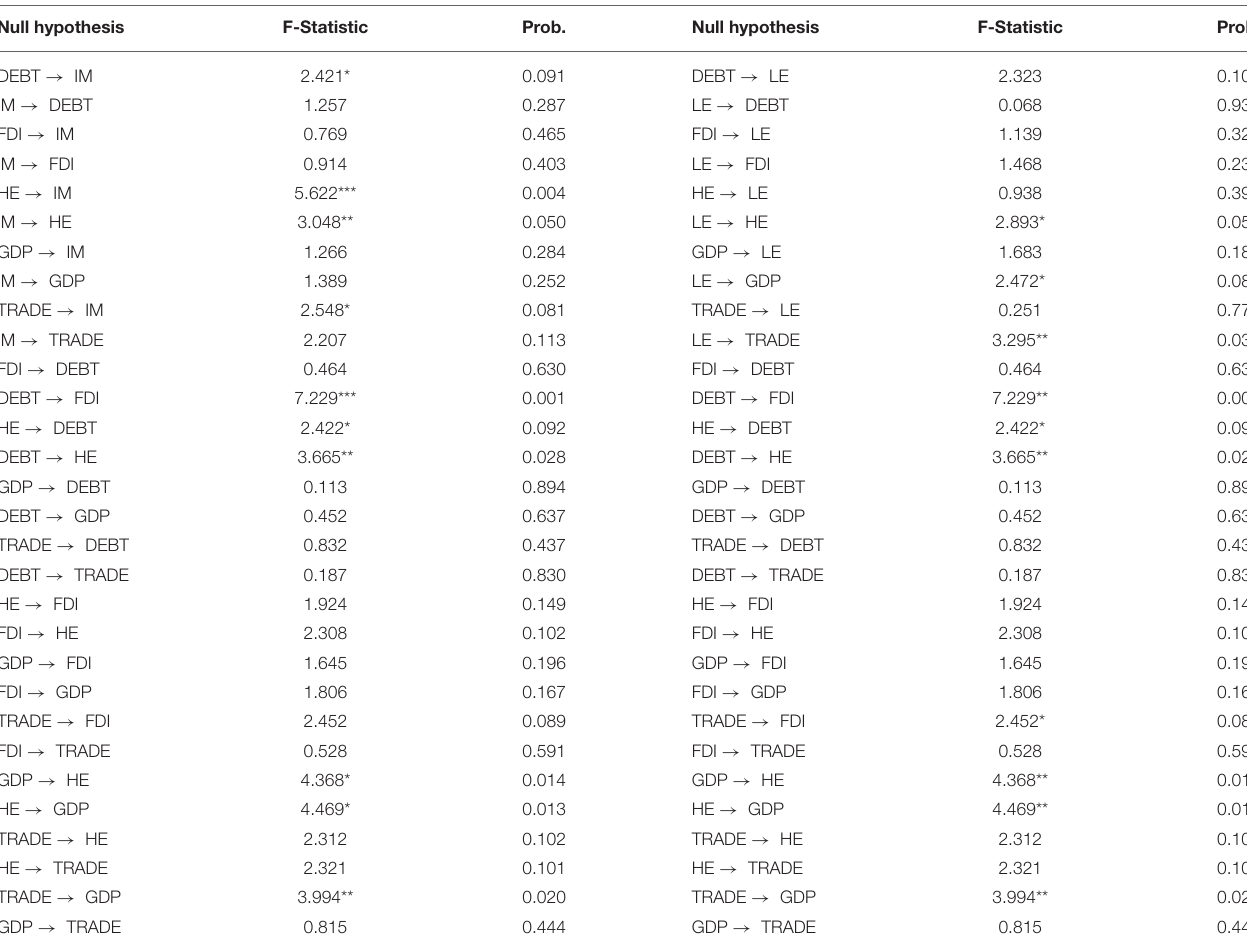
TABLE 4 | Panel causality